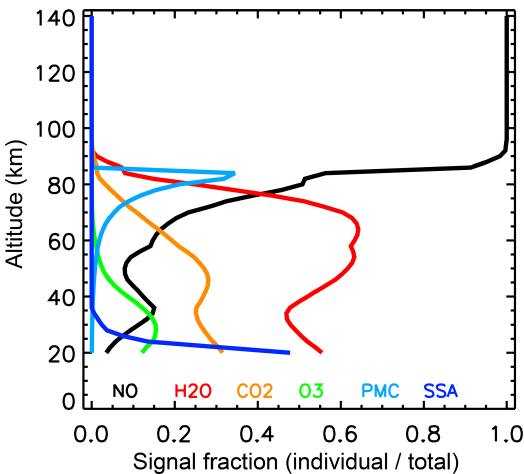
Figure 2. Relative contribution of various gases, PMCs (a layer from 81 to 87km, centered at 84km), and stratospheric sulfate aerosols (SSAs), in the SOFIE 5.32µm band used to measure NO. The results were simulated using average conditions near 66 ◦ S lat- itude in